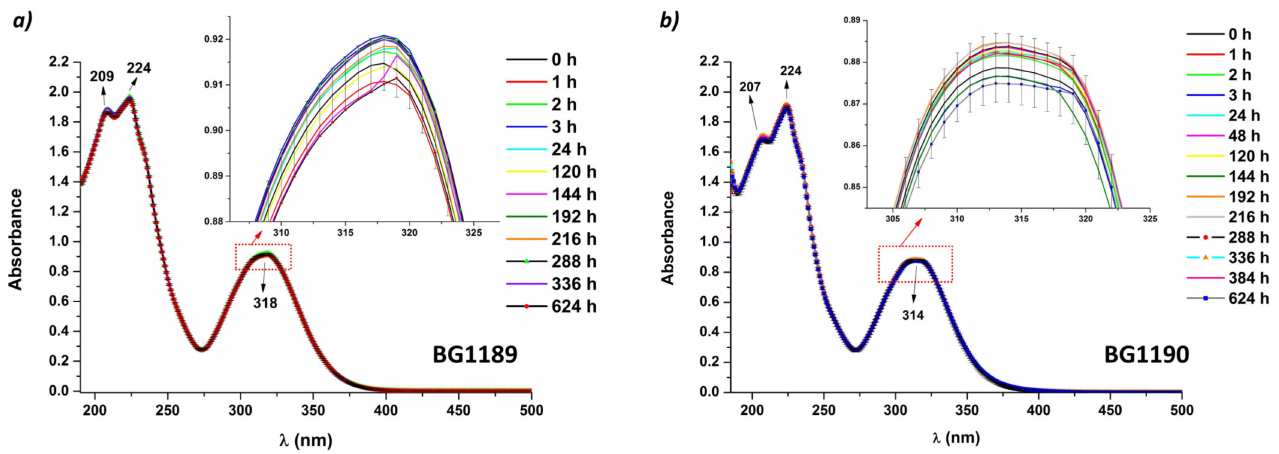
Figure 2. Time evolution of absorption spectra of quinazoline derivatives: ( a ) BG1189 and ( b ) BG1190. Solutions prepared in ultrapure water at 10 − 3 M; kept in dark, at 22 ◦